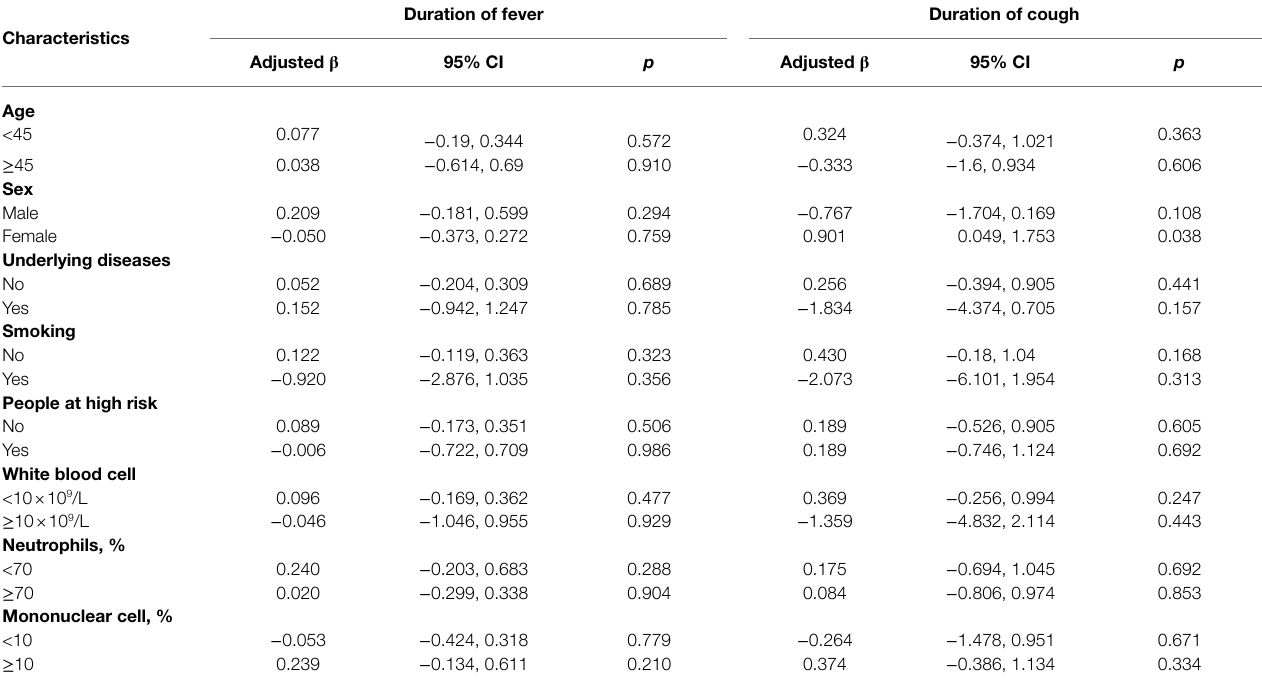
TABLE 6 | Outcomes of the duration days of fever for the patients infected with influenza virus with or without oseltamivir therapy.